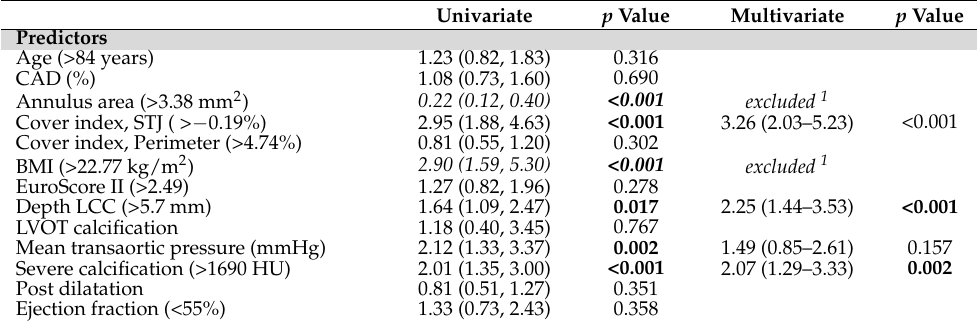
Table 5. Predictors of